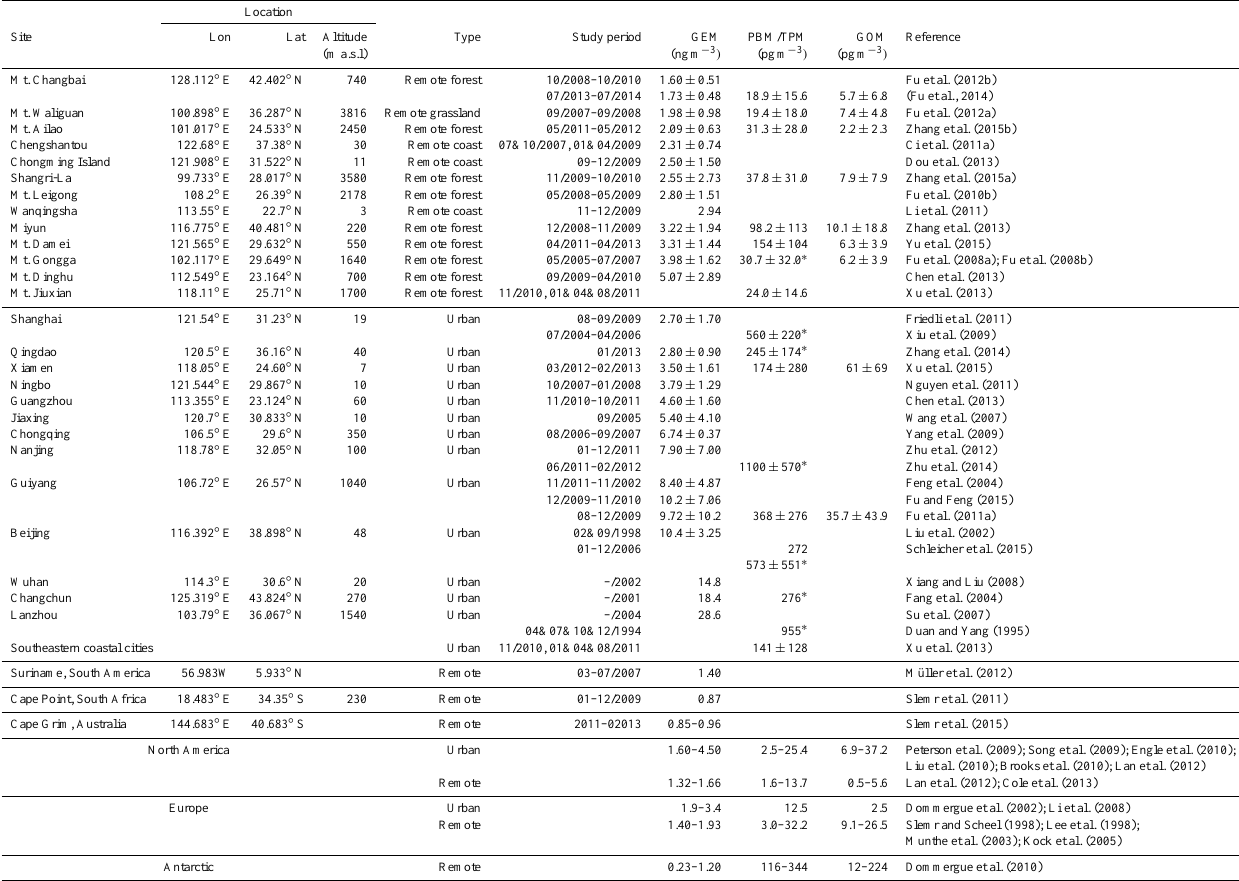
Table 1. Atmospheric Hg concentrations at ground-based stations in China and other regions